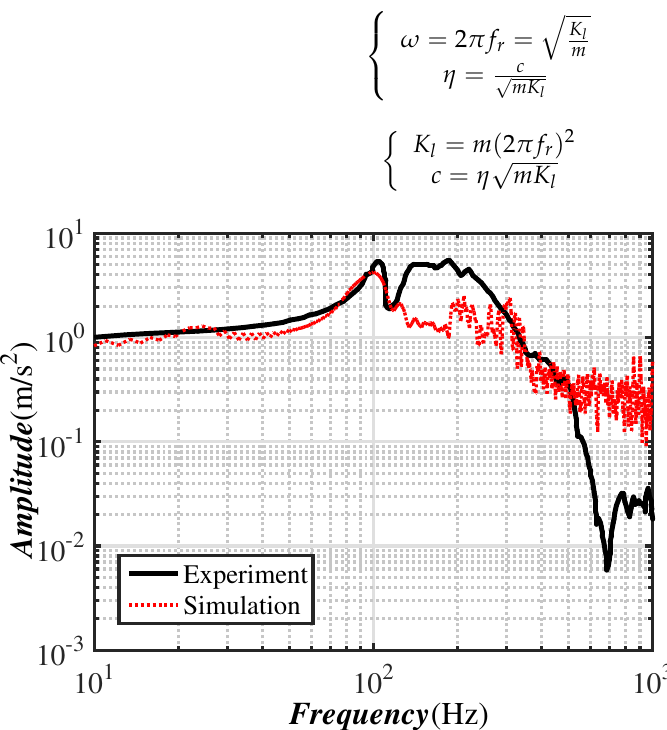
Figure 9. Response of the isolation system during the frequency sweep